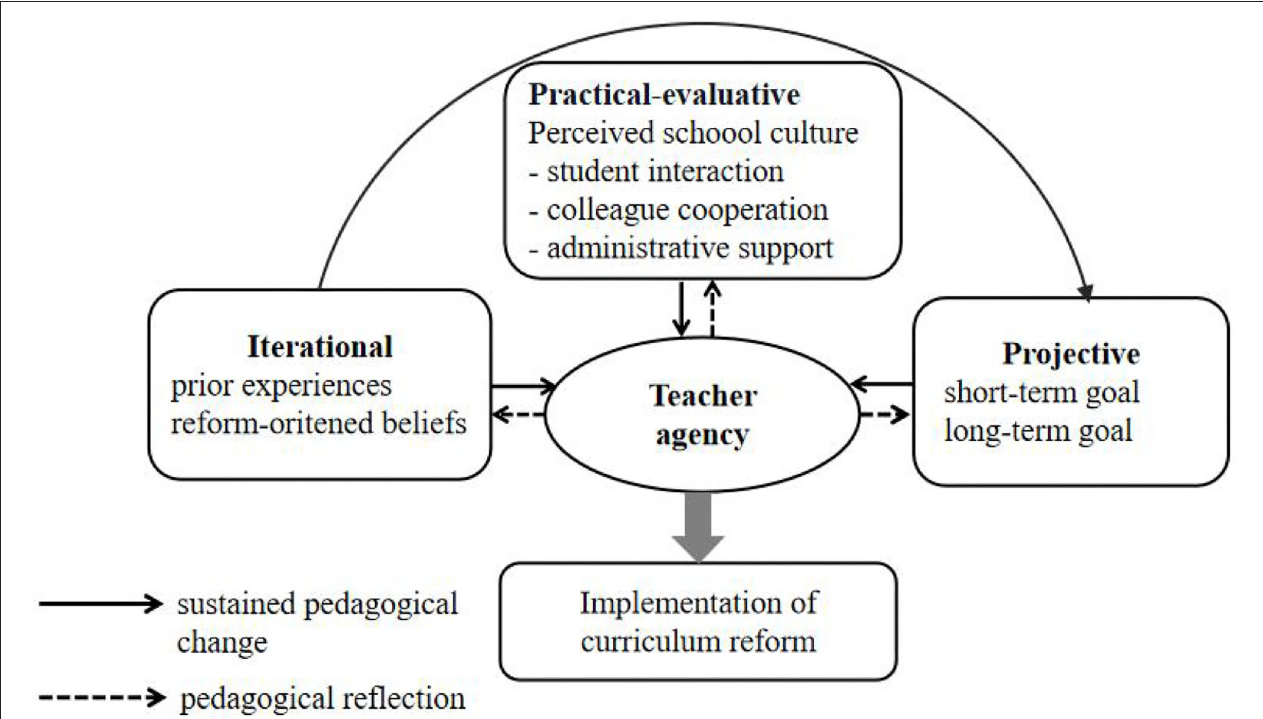
FIGURE 2 | Formation of language teachers’ agency in a curriculum reform context. Adapted from Priestley et al. (2015), with permission from Bloomsbury Academic through PLS